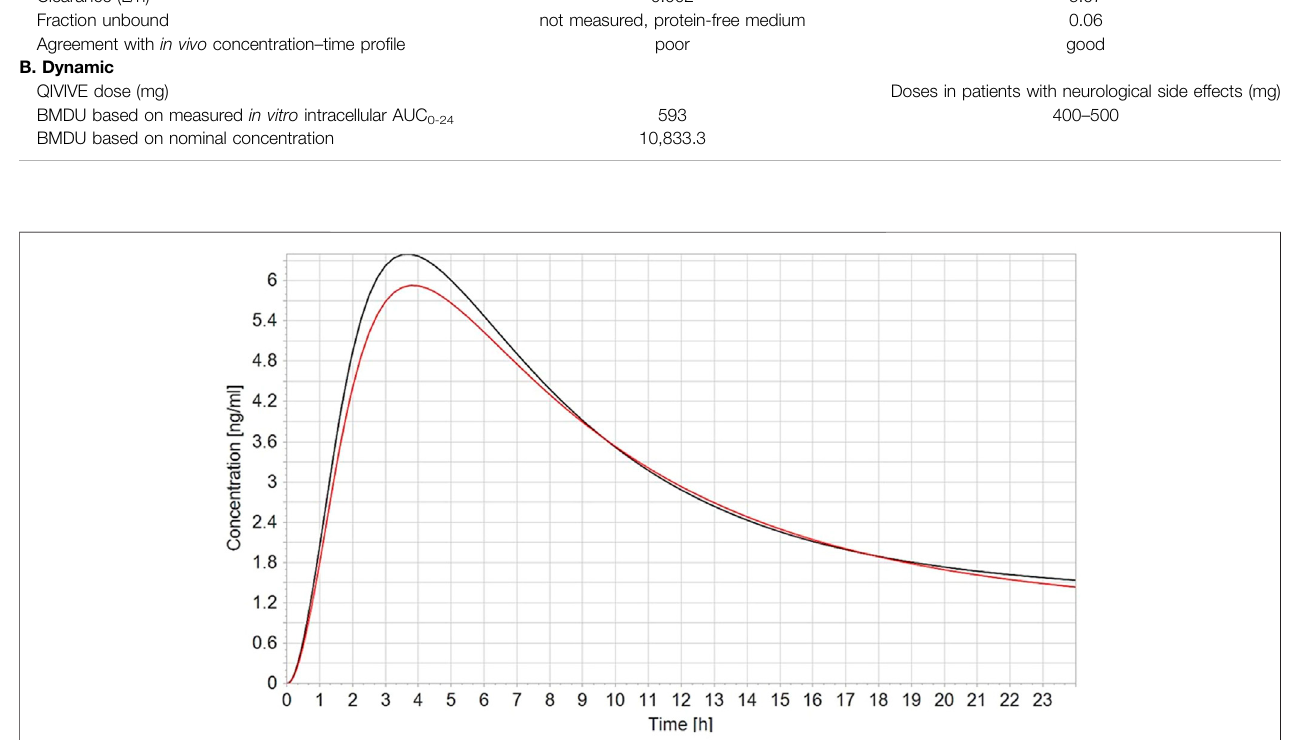
FIGURE 3 | Simulated plasma CPF concentration – time pro fi le in non-pregnant (black line) vs. pregnant (red line) population ( n = 100) after a single oral dose of 2 mg/kg.